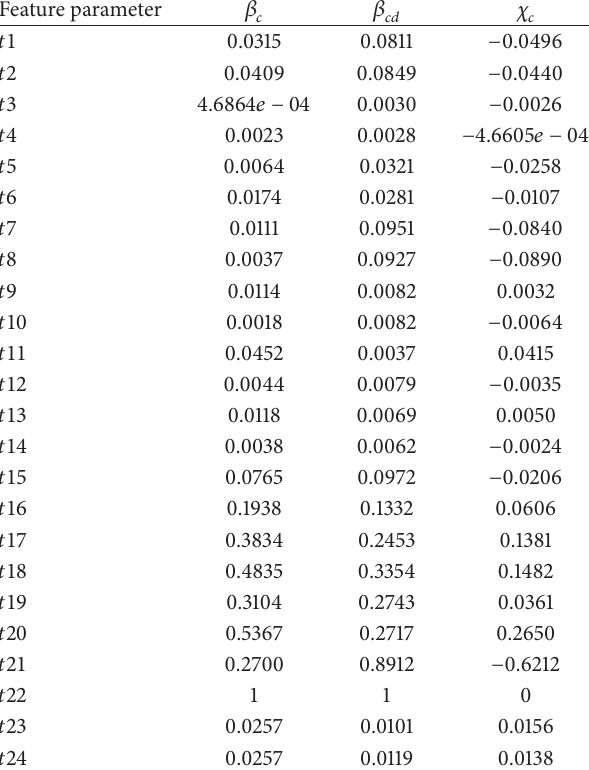
Table 2: Distance evaluation factors and their differences between 𝛽 𝛽 𝑐 and 𝑐𝑑